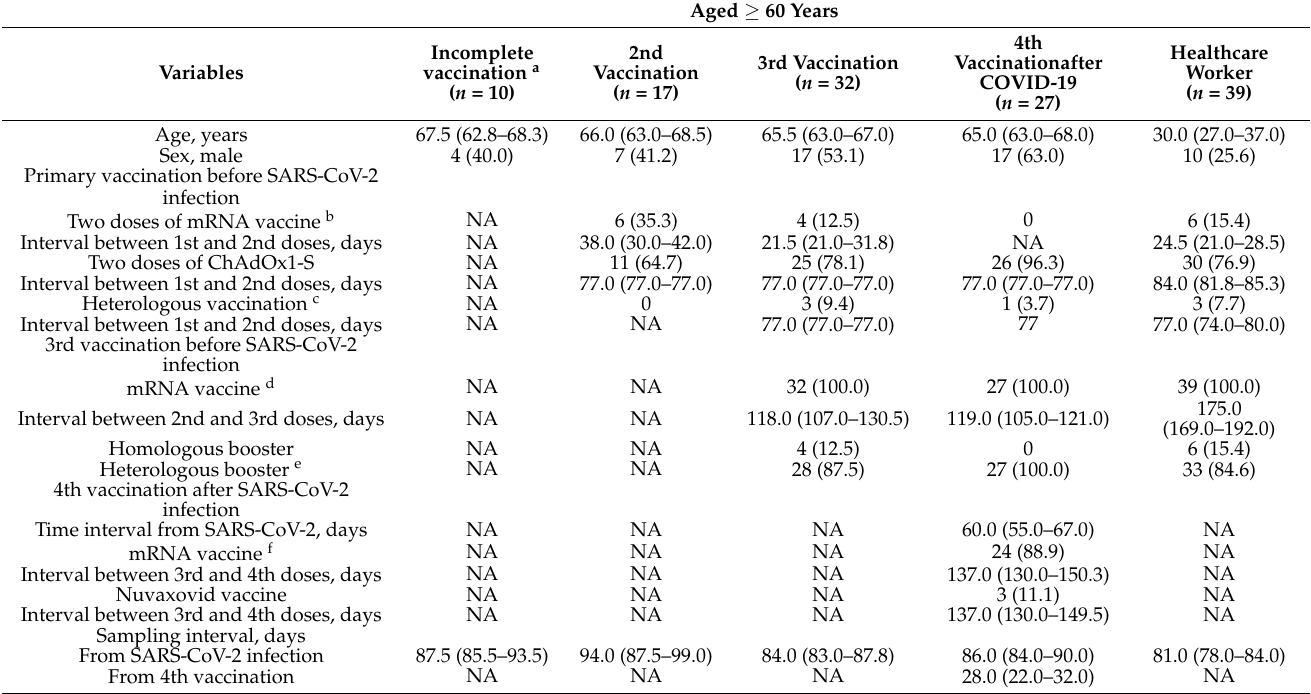
Table 1. Demographics of each cohort of patients according to their vaccination history before and after SARS-CoV-2